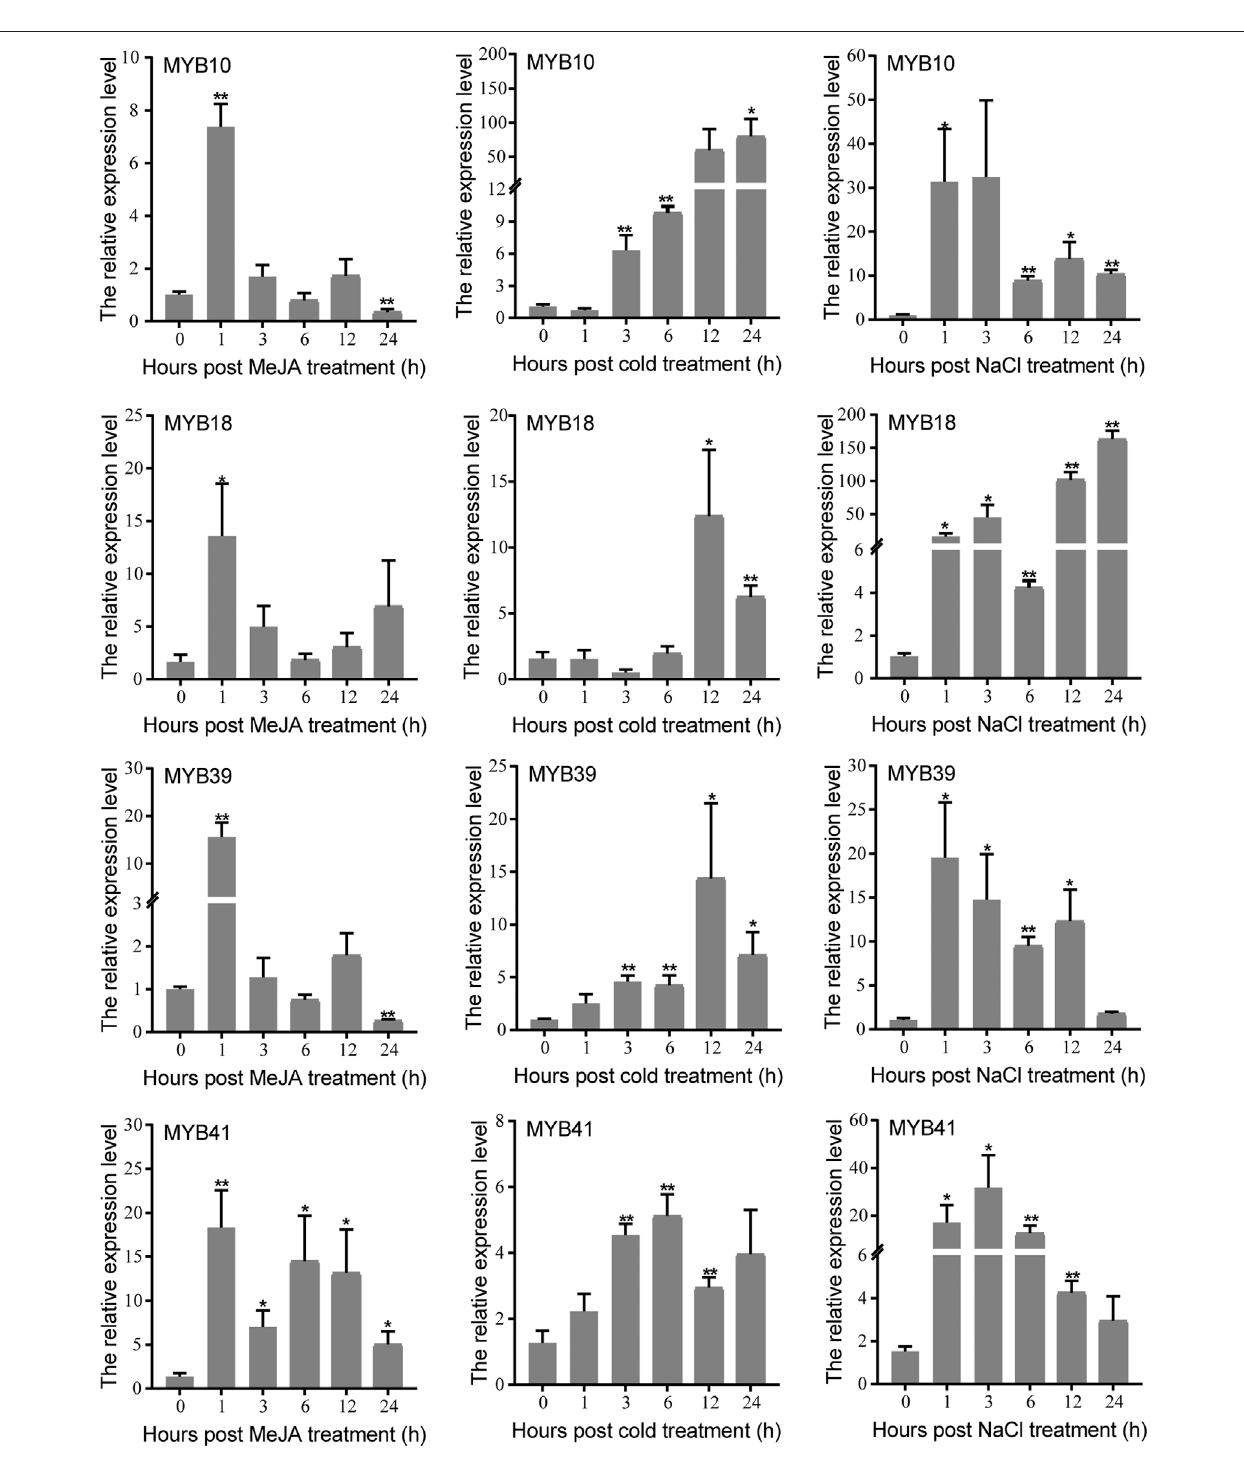
FIGURE 7 | Expression levels of four candidate R2R3-type CwMYB s under cold, NaCl, and MeJA treatments. Three biological replicates were performed.Vertical bars refer to ±SE ( n = 3). Asterisks indicate signi fi cant differences (* p < 0.05; ** p < 0.01).